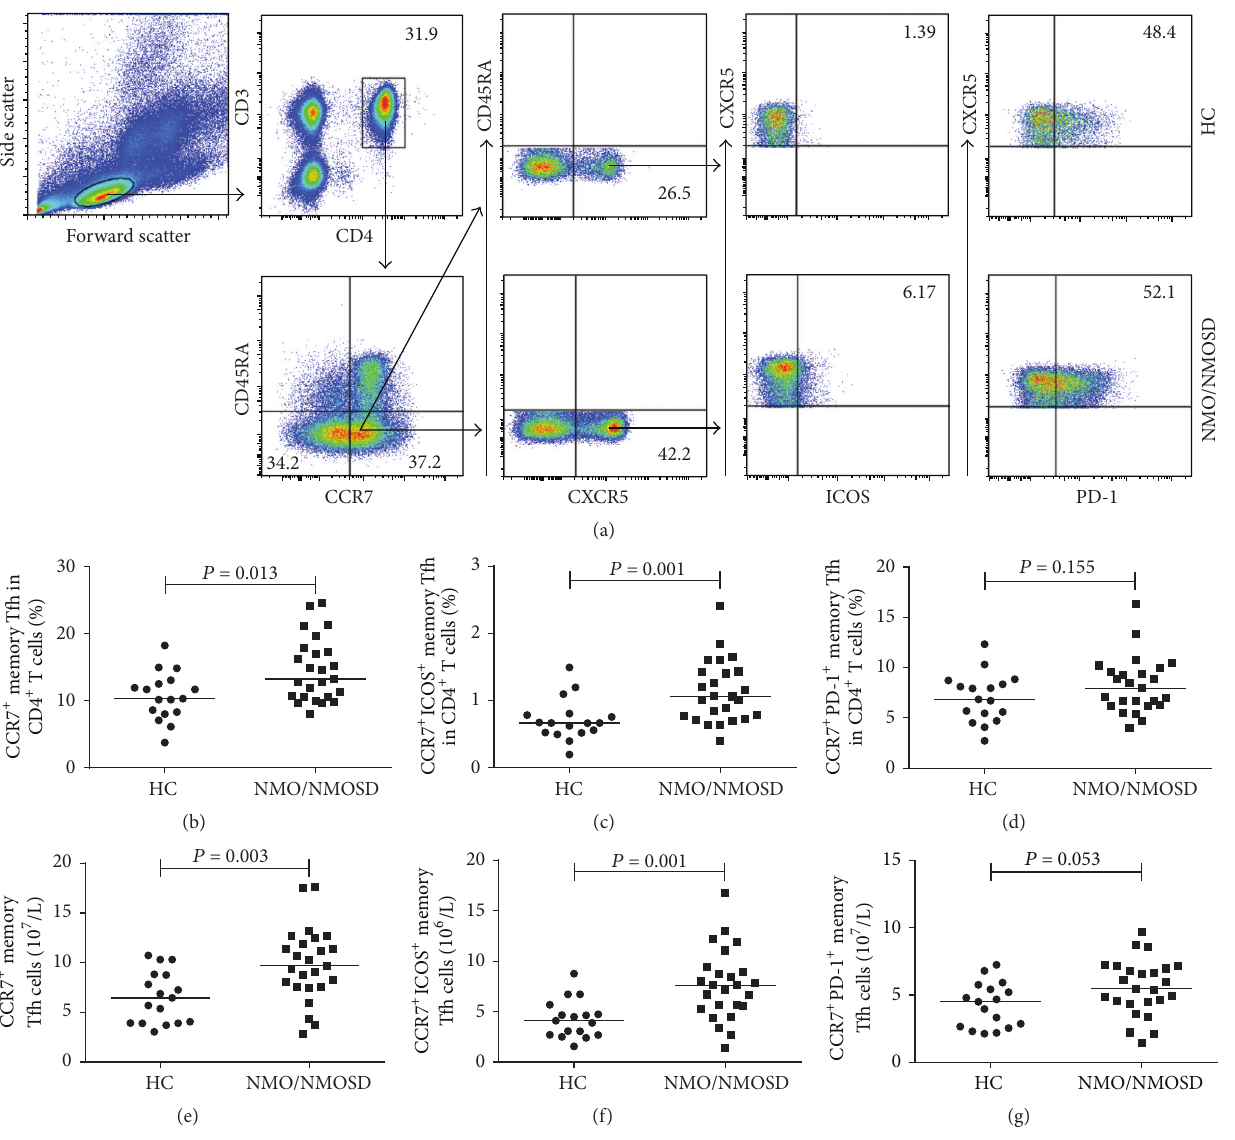
Figure 4: FACS analysis of circulating CCR7 + and CCR7 + ICOS + memory Tfh cells in individual participants. After staining with different fluorescent antibodies, the cells were gated sequentially on lymphocytes, CD3 + and CD4 + , and then CD45RA − and CCR7 + cells. After that, the cells were gated on CXCR5, and we obtained CD3 + CD4 + CD45RA − CCR7 + CXCR5 + (CCR7 + memory Tfh) cells. Subsequently, CCR7 + memory Tfh cells were gated on ICOS expression, and the percentages of CCR7 + and CCR7 + ICOS + memory Tfh cells were analyzed by flow cytometry. The numbers of each subtype of cells were calculated. (a) Flow cytometric analysis. ((b)-(c)) The percentages of circulating CCR7 + and CCR7 + ICOS + memory Tfh cells in HCs and untreated NMO/NMOSD patients. ((d)-(e)) The numbers of circulating CCR7 + and CCR7 + ICOS + memory Tfh cells in HCs and untreated NMO/NMOSD patients. The horizontal lines indicate the median values for each